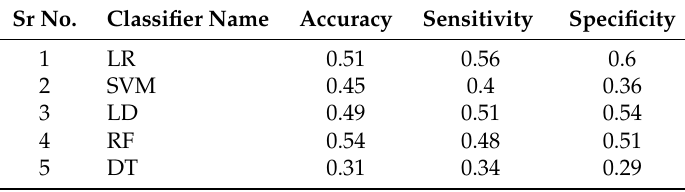
Table 2. 10-Fold Results based on the Top 10 Selected Features based on Proposed 3-Stage Approach. Sr No.